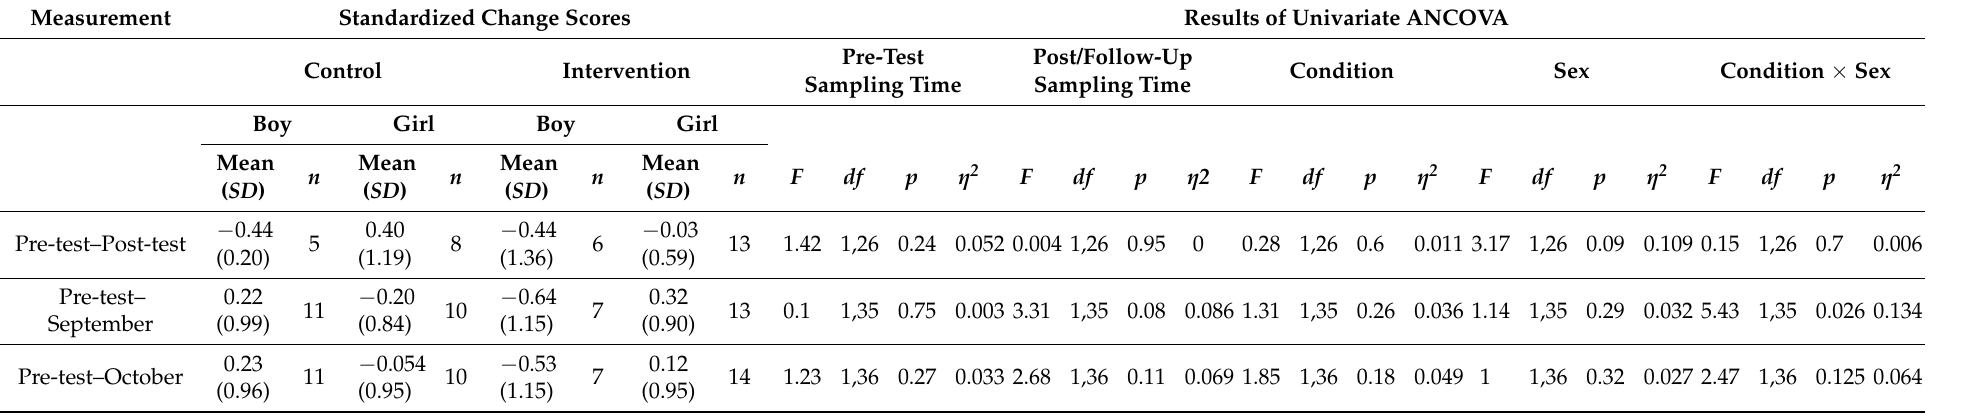
Table 3. Standardized change scores and the effects of the intervention on cortisol levels.